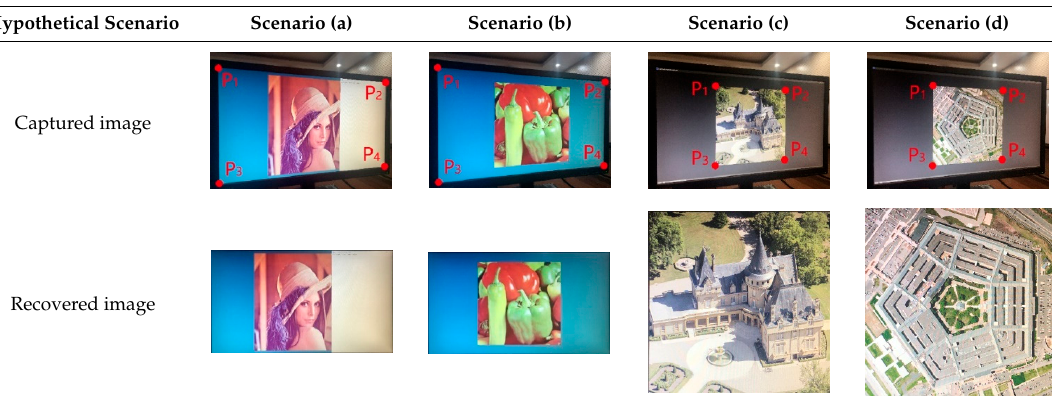
Table 6. Examples of Four Hypothetical Scenarios.